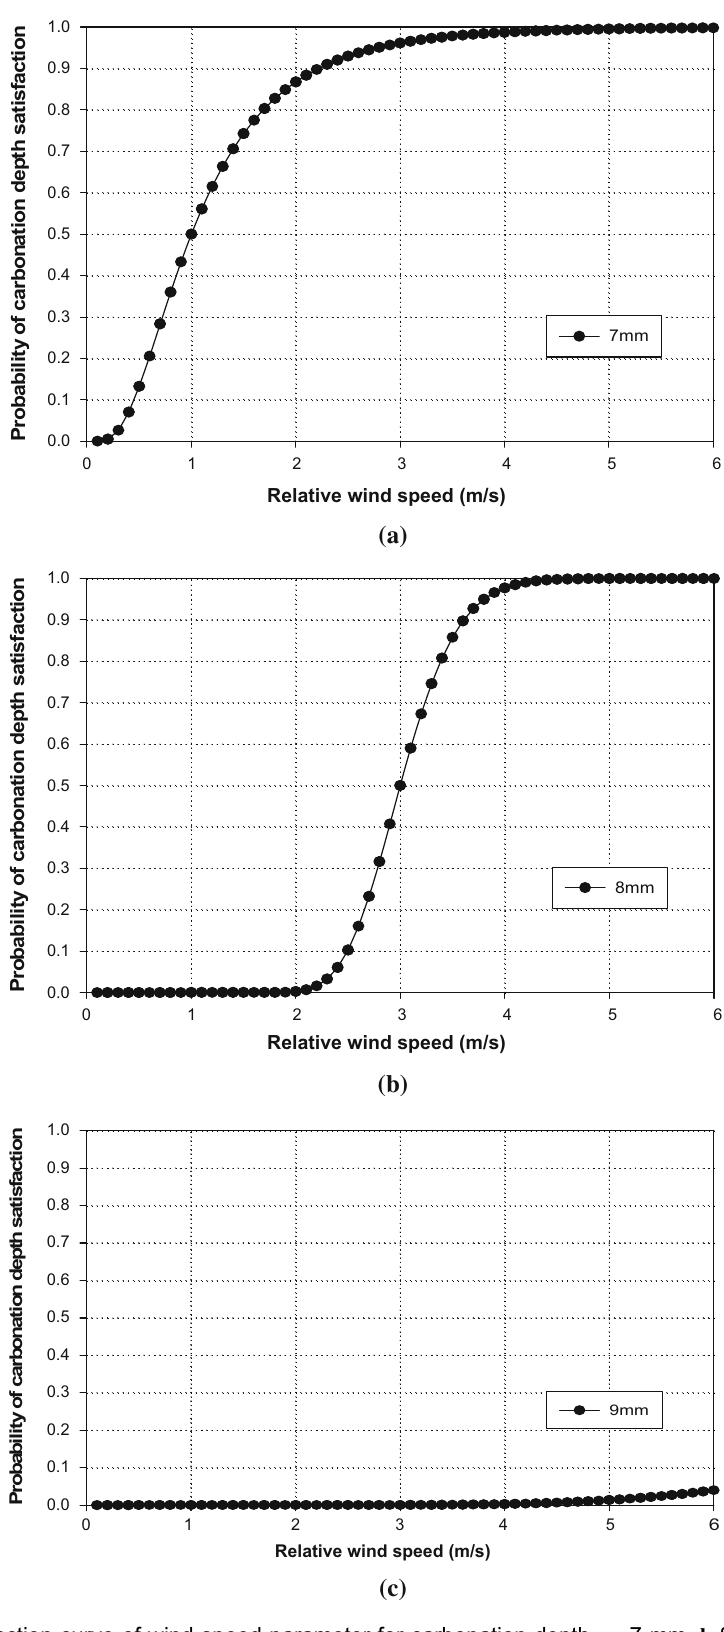
Fig. 4 Satisfaction curve of wind speed parameter for carbonation depth. a 7 mm, b 8 mm, c 9